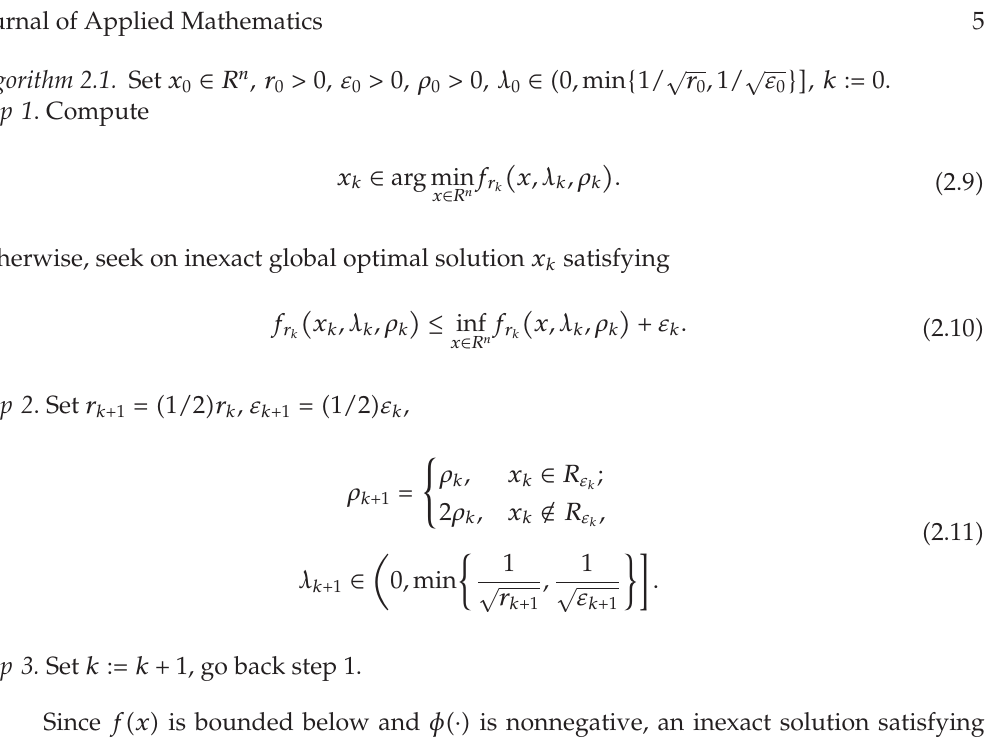
Algorithm 2.1. Set x 0 ∈ R n , r 0 > 0, ε 0 > 0, ρ 0 > 0, λ 0 ∈ (cid:2) 0 , min { 1 /